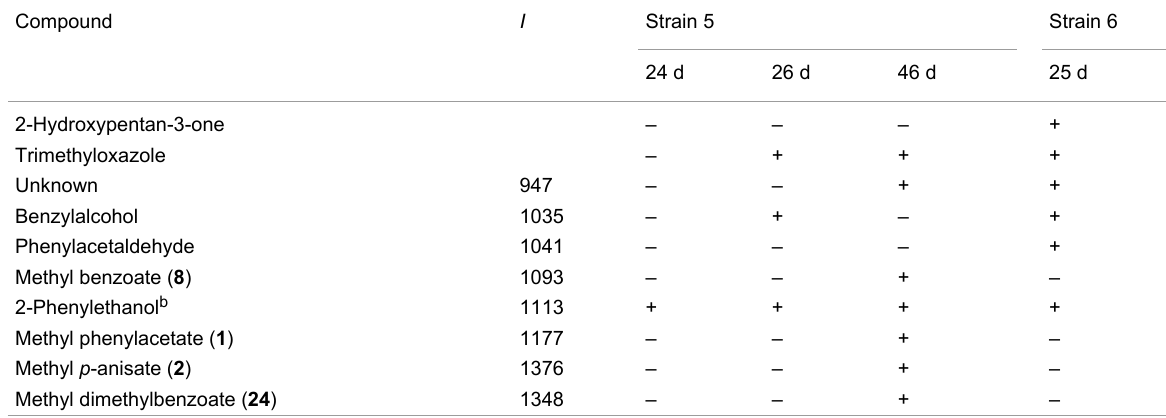
Table 7: Volatiles released by Mycobacterium tuberculosis grown in a Sauton liquid medium. a